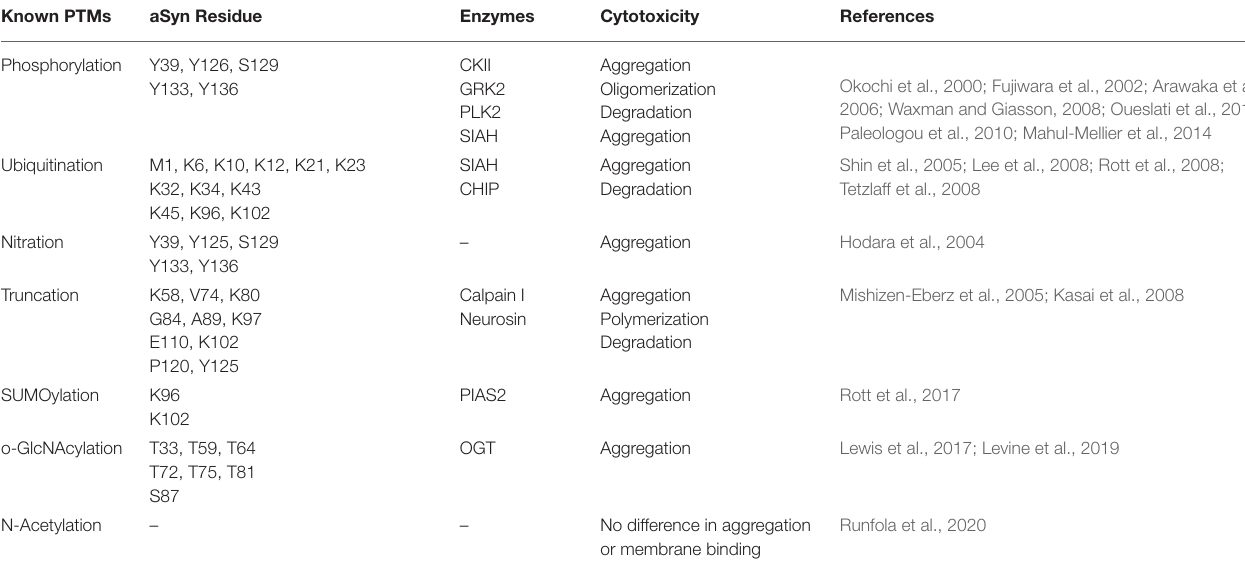
TABLE 2 | Known post-translational modifications in α Syn, sites, enzymes, and